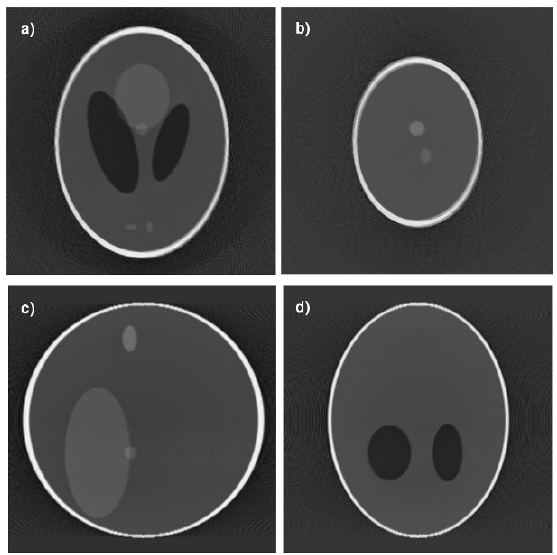
Figure 4. (a)&(b)axialslicesatz= − 2.5cmandz=6.5cm; (c)sagit- tal slice; (d) coronal slice.